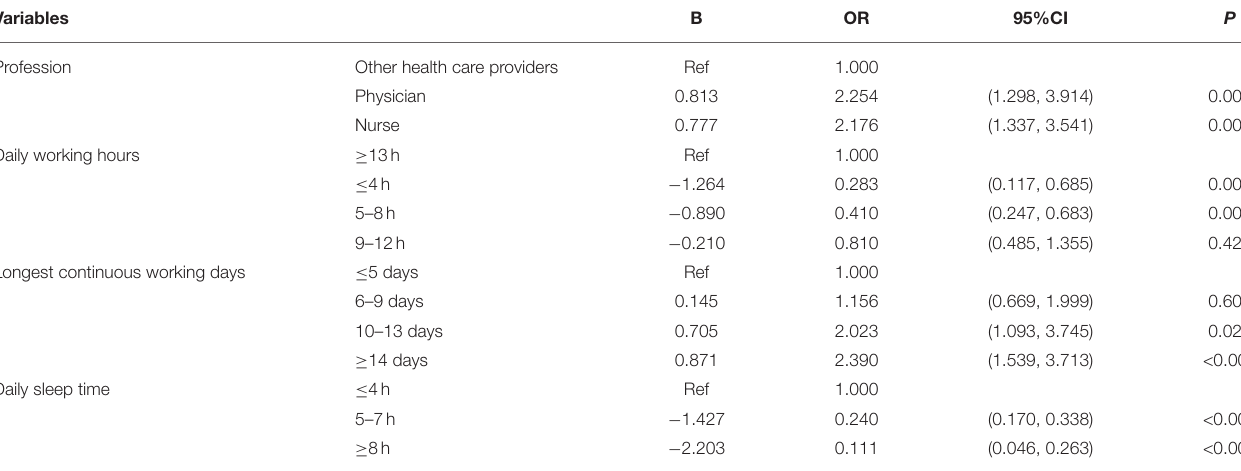
TABLE 3 | Binary logistic regression of risk factors associated with PTSD ( n = 1,993).